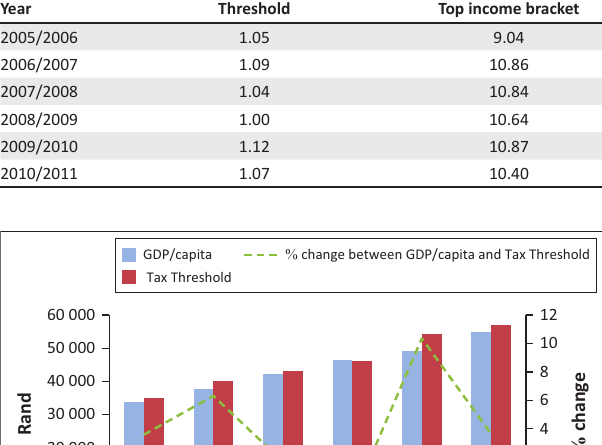
FIGURE 4: Inflation and percentage change in the tax threshold and top income bracket